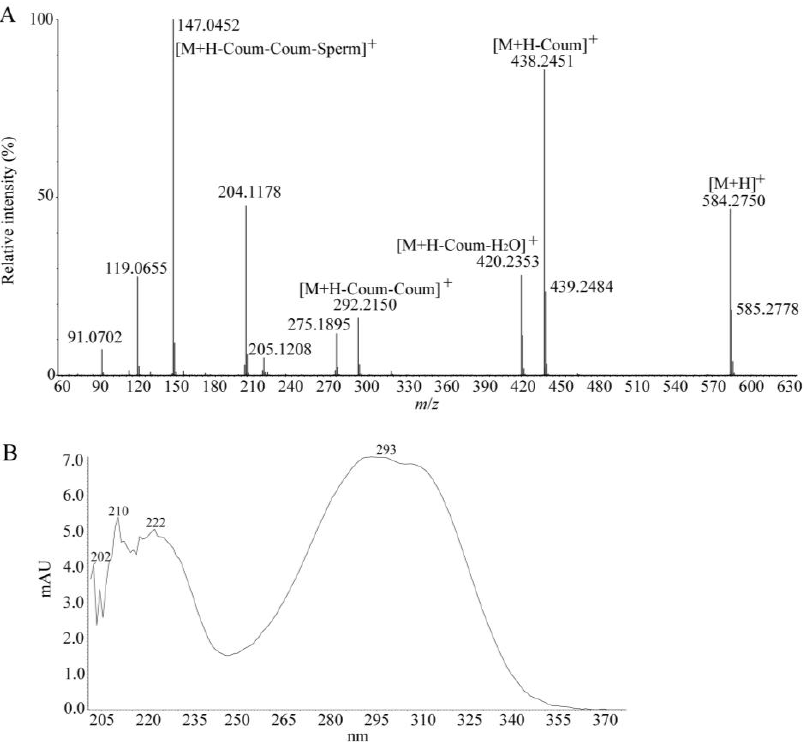
Figure 5. A spermidine derivative (compound 63 ) detected in tea flowers. ( A ) CID-MS/MS spectrum of compound 63 in the ESI + mode. ( B ) The UV spectrum of compound 63 extracted from the UPLC-PDA-QTOF MS experiment. mAU, milli absorption unit.